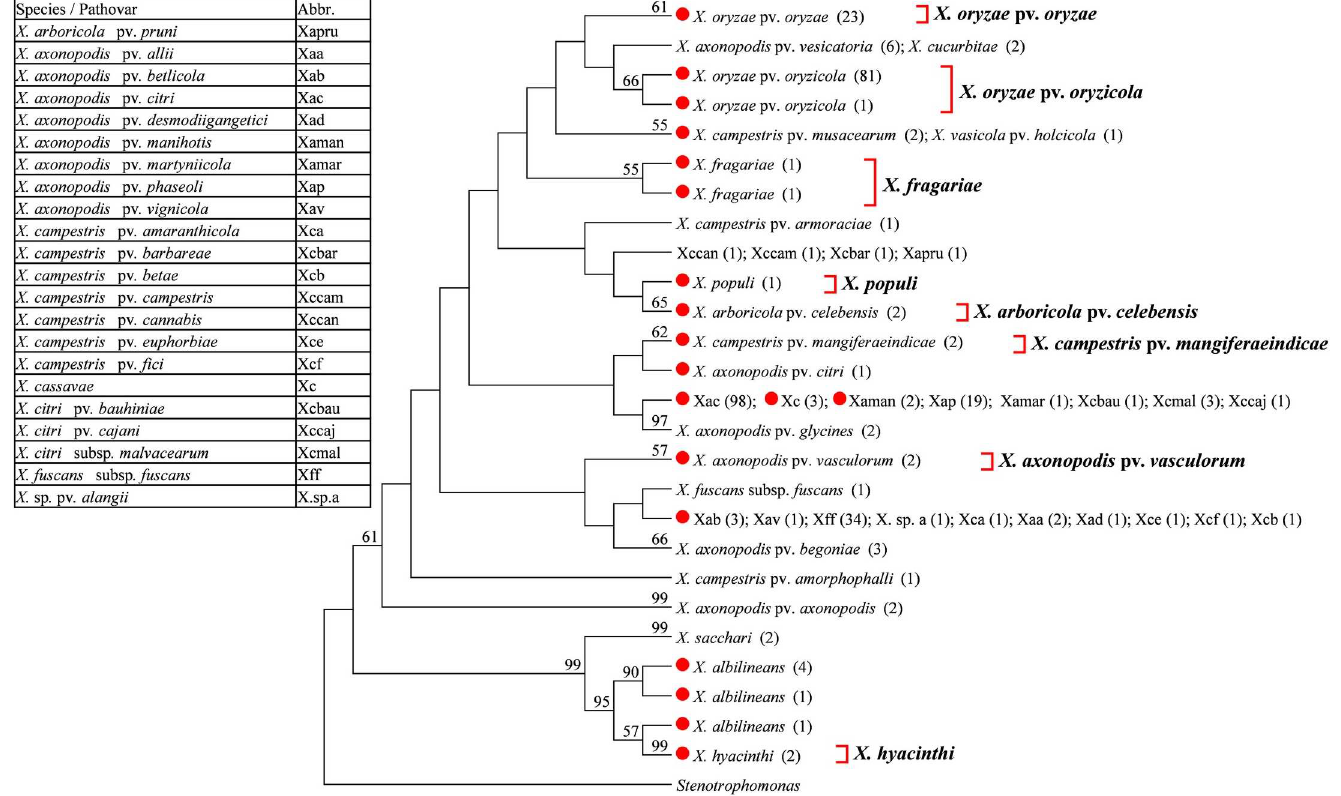
Fig 1. Neighbor-joining tree based on 16S rRNA gene. Bootstrap values ( > 50%)are shown above the branches. Identicalsequencesare represented only once. Numbersfollowingtaxon names indicate the number of isolates. Red dots indicatequarantine Xanthomonas species/pathovars. Species/ pathovars that were successfully identified are shown on the